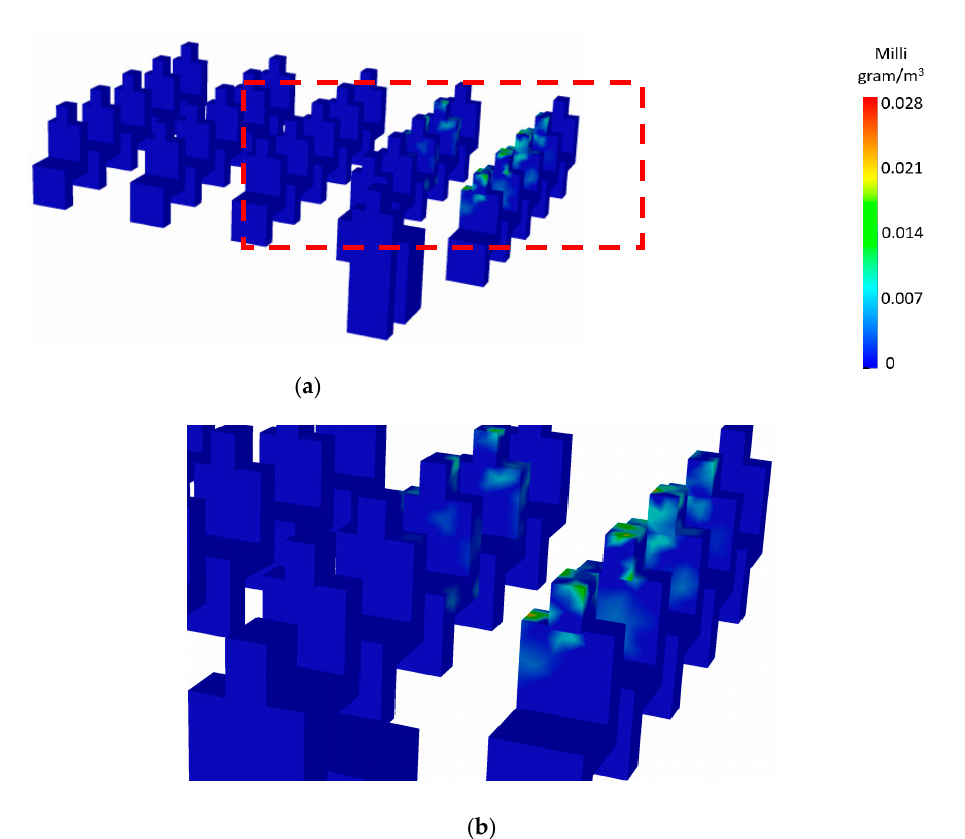
Figure 9. Time residence for dispersed aerosol droplets after 180 s.